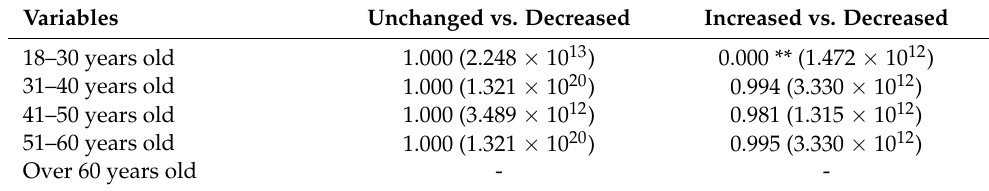
Table 2. Change in perceived importance of social health benefits explained by age.